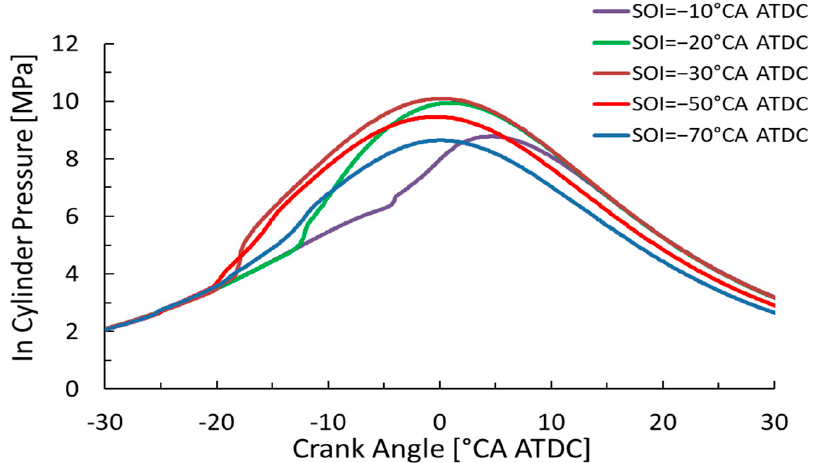
Figure 8. In-cylinder pressure history for a variety of SOI timings.